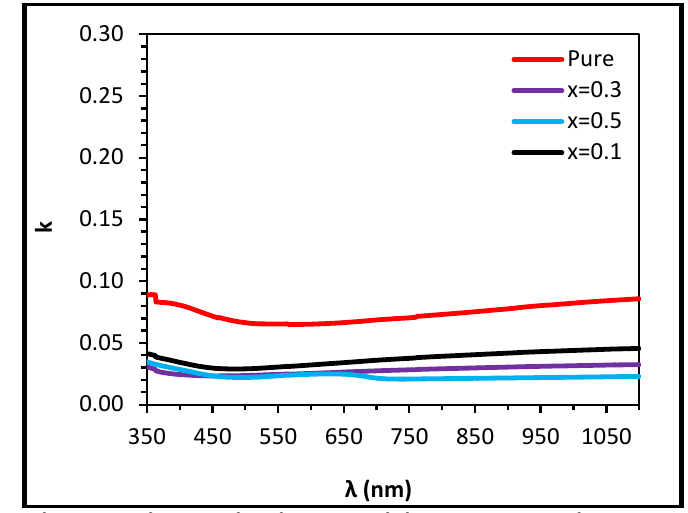
O :TiO at R.T. 2 5 2